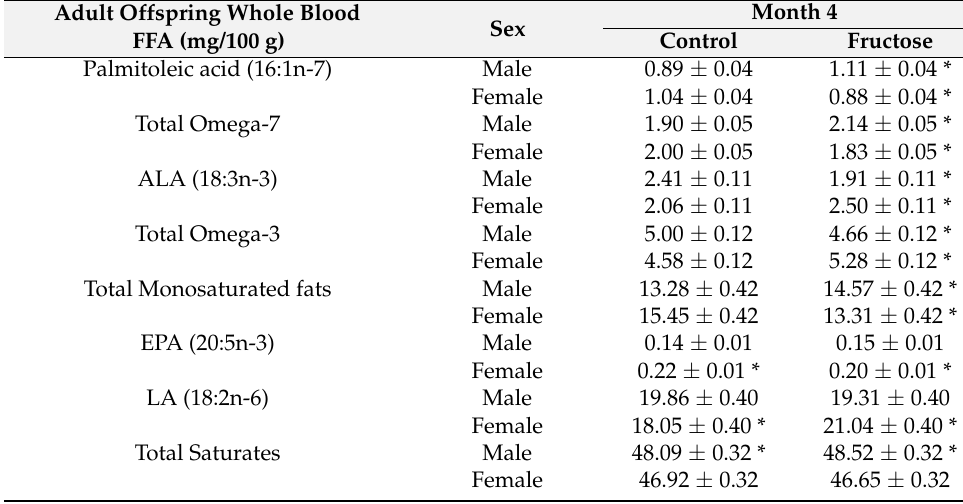
Table 2. Free fatty acid concentrations in fructose adult offspring whole blood at month